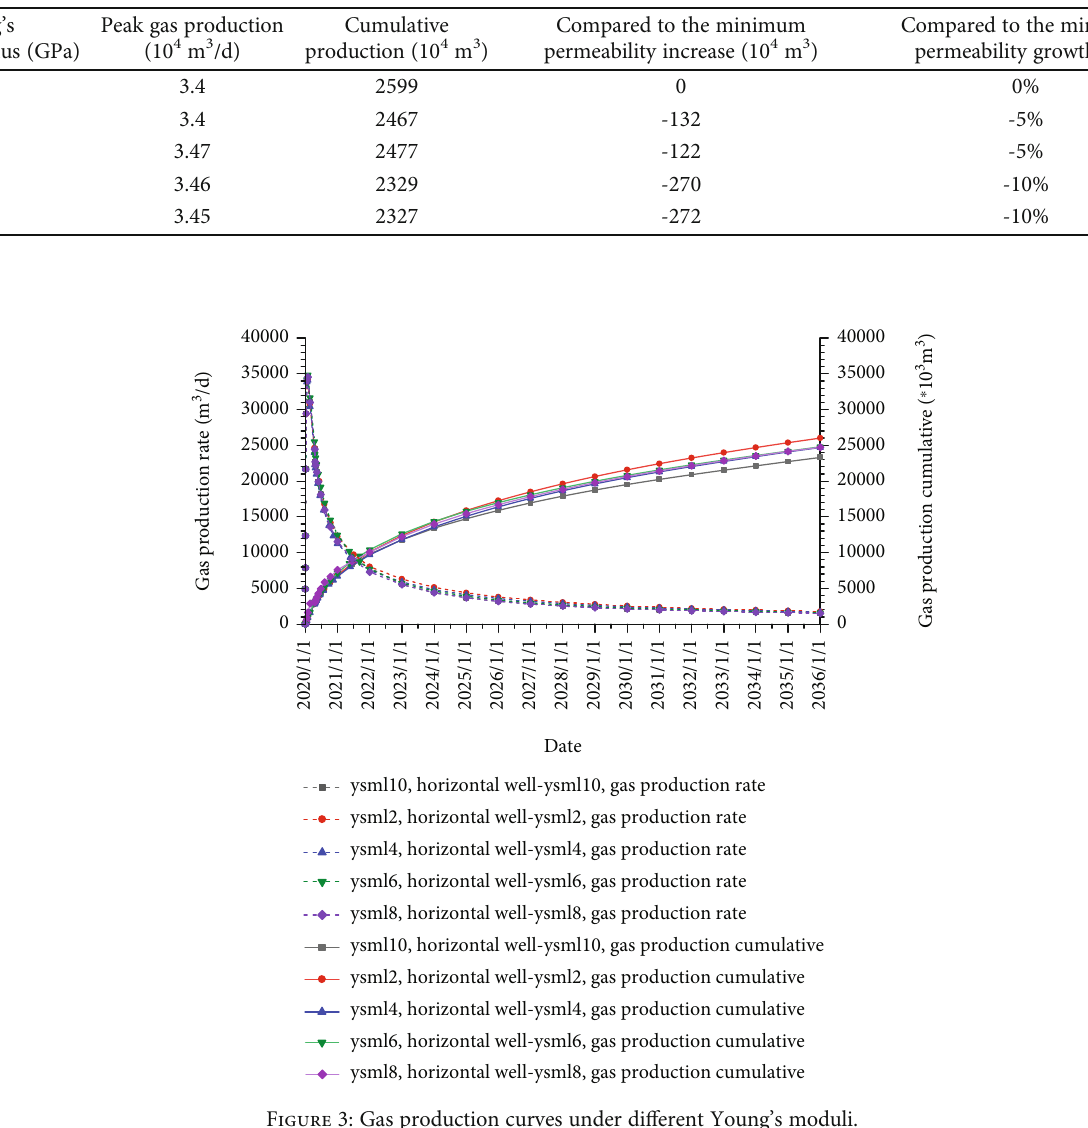
Table 4: Gas production condition with di ff erent Young ’ s moduli.